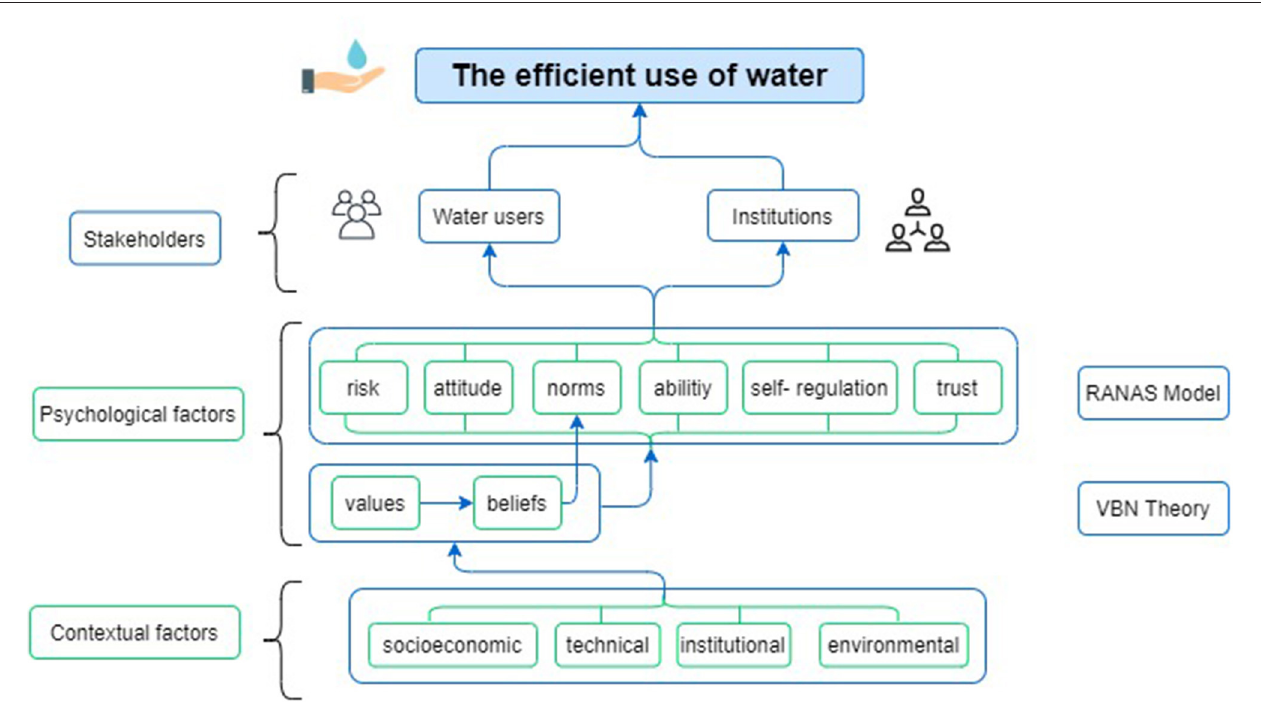
FIGURE 3 | Elaboration of contextual and psychological factors within the conceptual